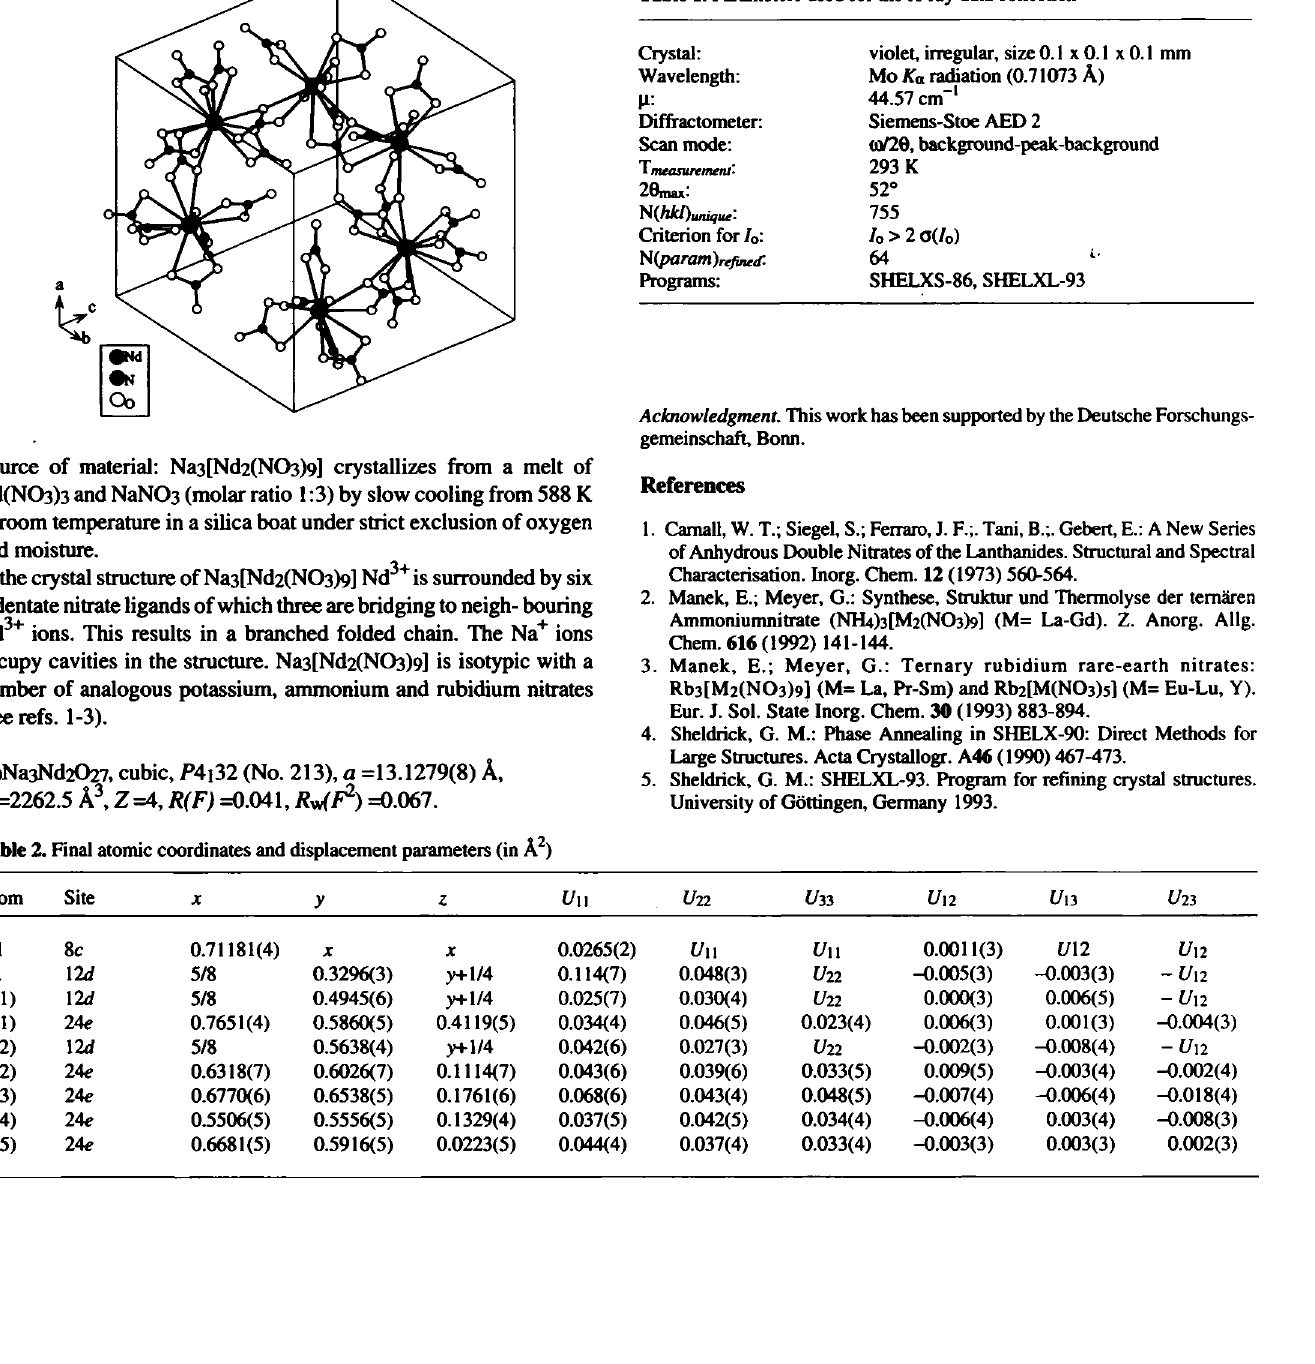
Table 1. Parameters used for the X-ray data collection